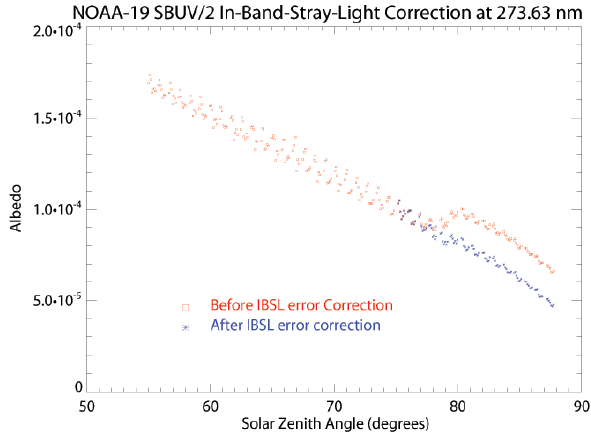
Fig. 16. Sample of N19 albedo measurements at 273nm near the North Pole before and after the IBSL correction.